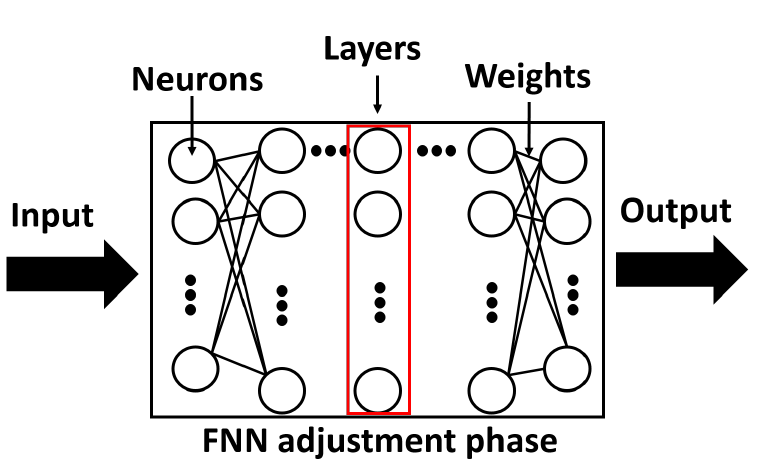
Figure 2. Fundamental architecture of an FNN with the interaction of each component